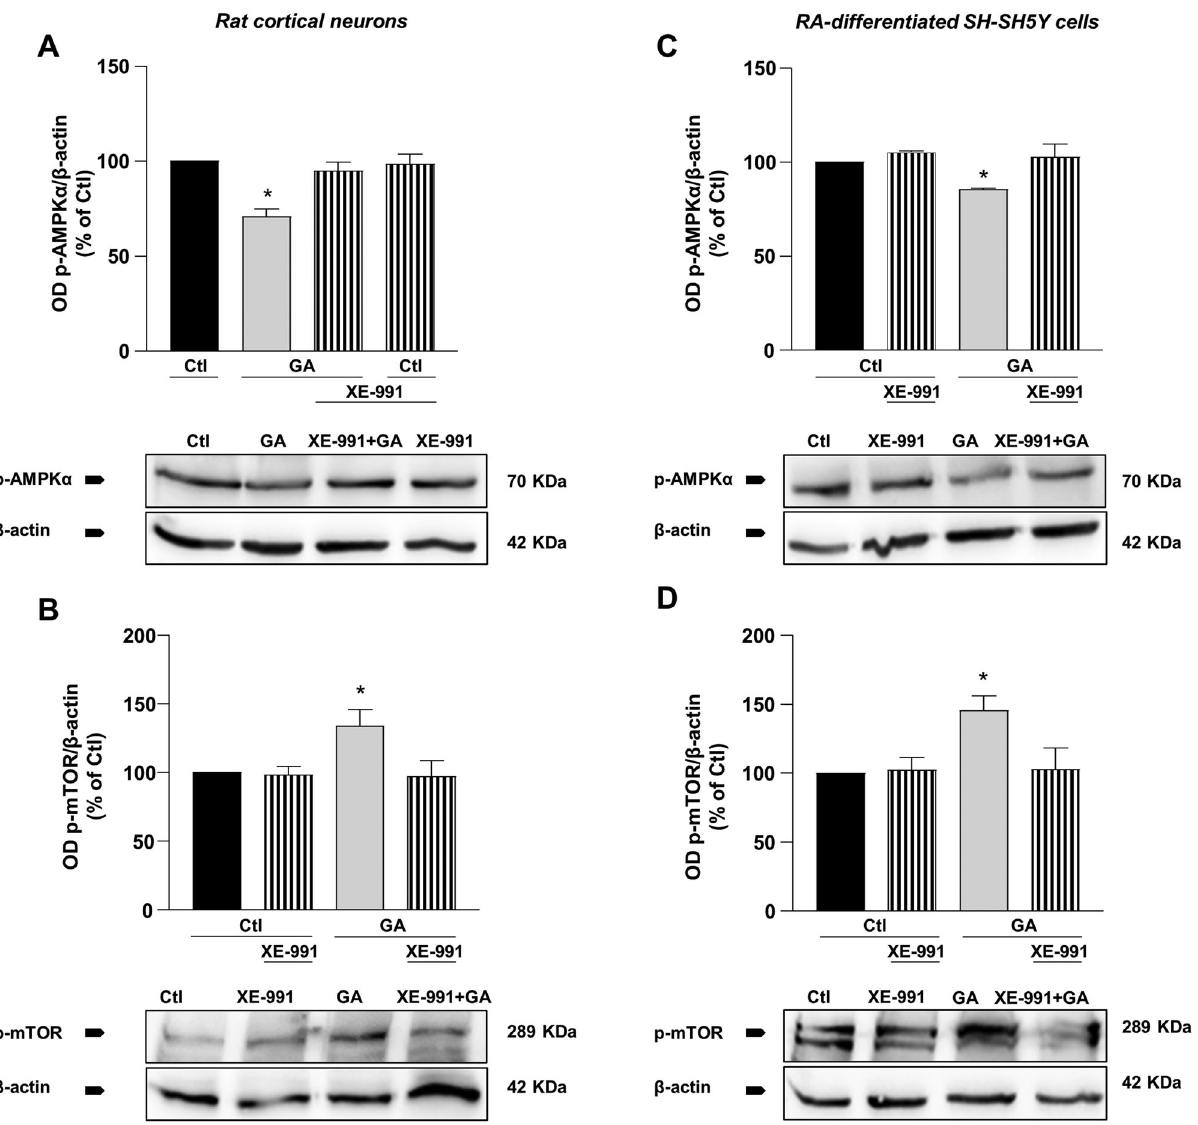
Fig. 7 Effect of XE-991 on AMPK/mTOR pathway in primary rat cortical neurons and RA differentiatedSH-SY5Y cells challenged with GA. Quanti fi cation of ( A , C ) p-AMPK α and ( B , D ) p-mTOR expression in primary rat cortical neurons ( A , B ) and RA-differentiated SH-SY5Y ( C , D ) treated with GA and exposed to XE-991. As loading control, β -actin was used. Normalized optical density values were reported as control percentages. Differences among means were evaluated by one-way ANOVA followed by Dunnett ’ s post hoc test. A F (3, 12) = 11.47. Each column depicts the mean ± S.E.M. of four independent experiments. *Signi fi cant versus all groups ( p < 0.001 versus Ctl; p < 0.01 versus XE-991 and XE-991 + GA). B F (3, 12) = 4.096. Each column depicts the mean ± S.E.M. of four independent experiments. *Signi fi cant versus all groups ( p < 0.05). C F (3, 11) = 5.592. Each column depicts the mean ± S.E.M. of at least three independent experiments. *Signi fi cant versus all groups ( p < 0.05). D F (3, 12) = 4.903. Each column depicts the mean ± S.E.M. of at least three independent experiments. *Signi fi cant versus all groups ( p <